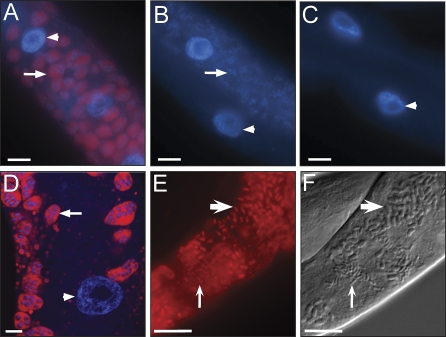
Intracellular Microbe Is a Novel Microsporidia Species(A–E) FISH staining of C. elegans intestines using Cy3 probes for rRNA in red and (A–D) counterstained with DAPI in blue to label DNA.(A) Infected animal at the groove stage stained with MicroA, a probe specific for N. parisii rRNA. Arrow indicates FISH and DAPI staining of multinucleate microbes (meronts). Similar results were obtained with MicroB, another probe specific for N. parisii (unpublished data).(B) Infected animal at the groove stage stained with universal probe for bacterial rRNA (EUB338) [67]. No FISH staining is observed, although excess DAPI staining is visible due to meronts, indicated with arrow.(C) Uninfected animal stained with N. parisii-specific probe. For (A–C) scale bar is 10 μm.(D) Confocal imaging of FISH staining with N. parisii-specific probe. Arrow indicates multinucleate microbes (meronts). Scale bar is 5 μm. For (A and D), arrowhead indicates host nucleus.(E) rRNA FISH staining of rod-shaped microbes (spores) with N. parisii-specific probe.(F) DIC image of spores. For (E and F), small spores indicated with smaller arrow, large spores indicated by larger arrow, and scale bar is 10 μm.